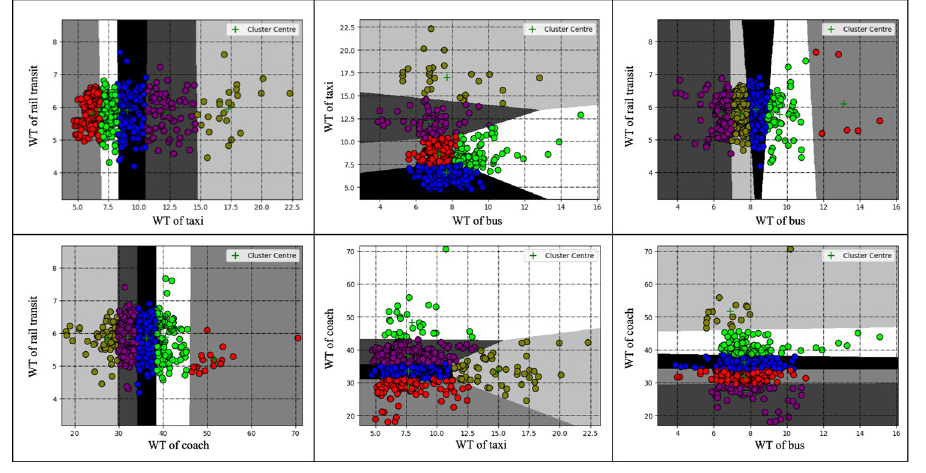
Fig 7. WT cluster analysis results.